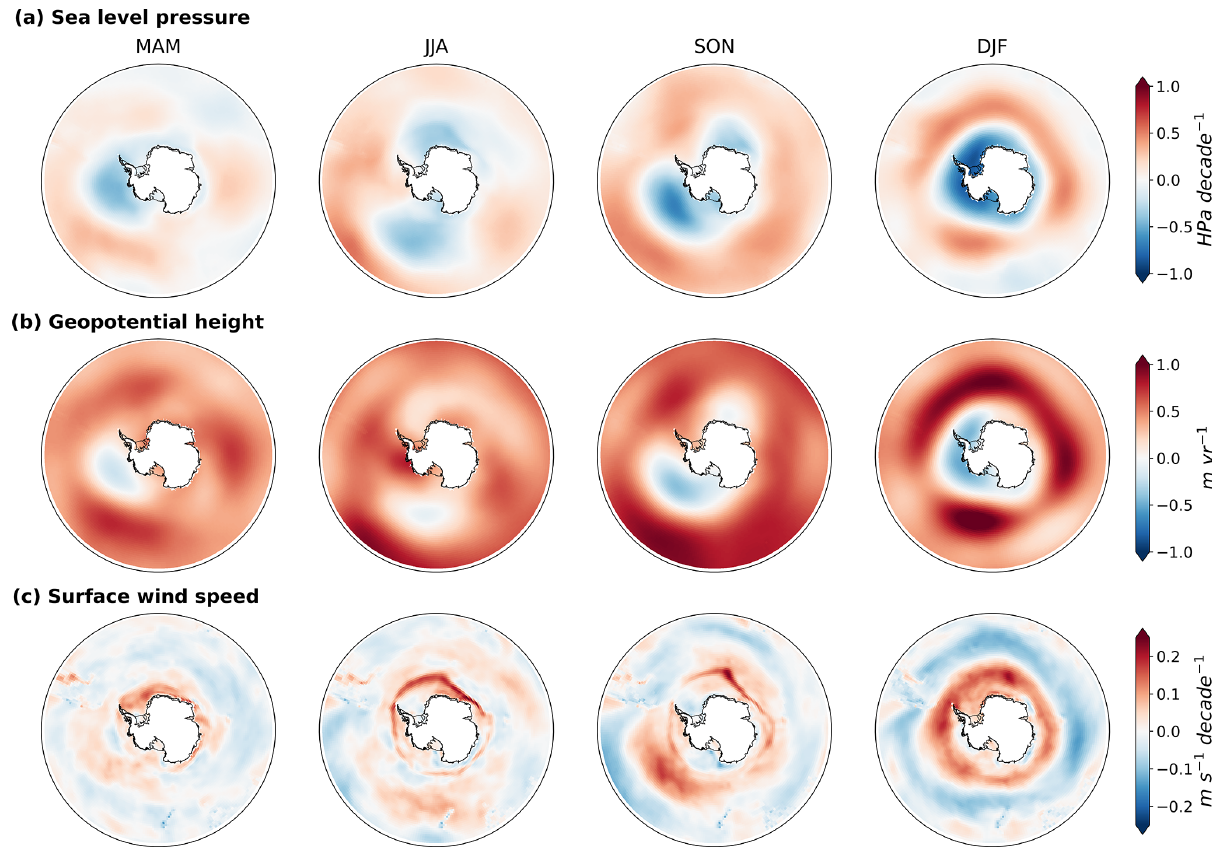
Figure A4. 1979–2015 CESM2 seasonal trends in (a) sea level pressure around the AIS, (b) 500hPa geopotential height, and (c) surface wind speed over the Southern Ocean.